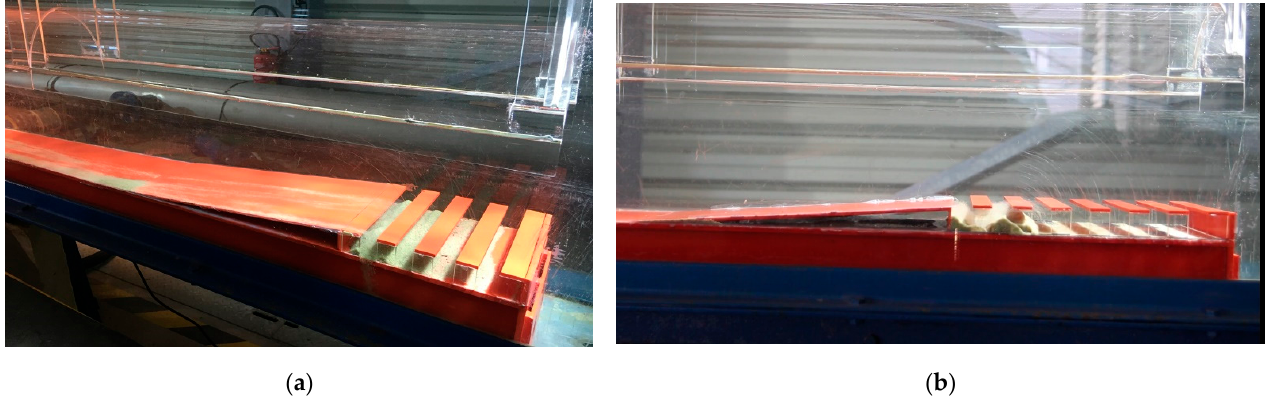
Figure 13. Ramp and ribs solution for safely trapping sediments as a retrofitting proposal. Physical model test with 1:1 sediment and 1:1 velocity scaling ribs and ramp solution at weir. ( a ) Sand as a bedload on 8% inclined ramp and 5 ribs/4 gaps; ( b ) trapped under, by ribs and ramp structure of 7 ribs/7 gaps, and protected by flow separation underneath ribs.